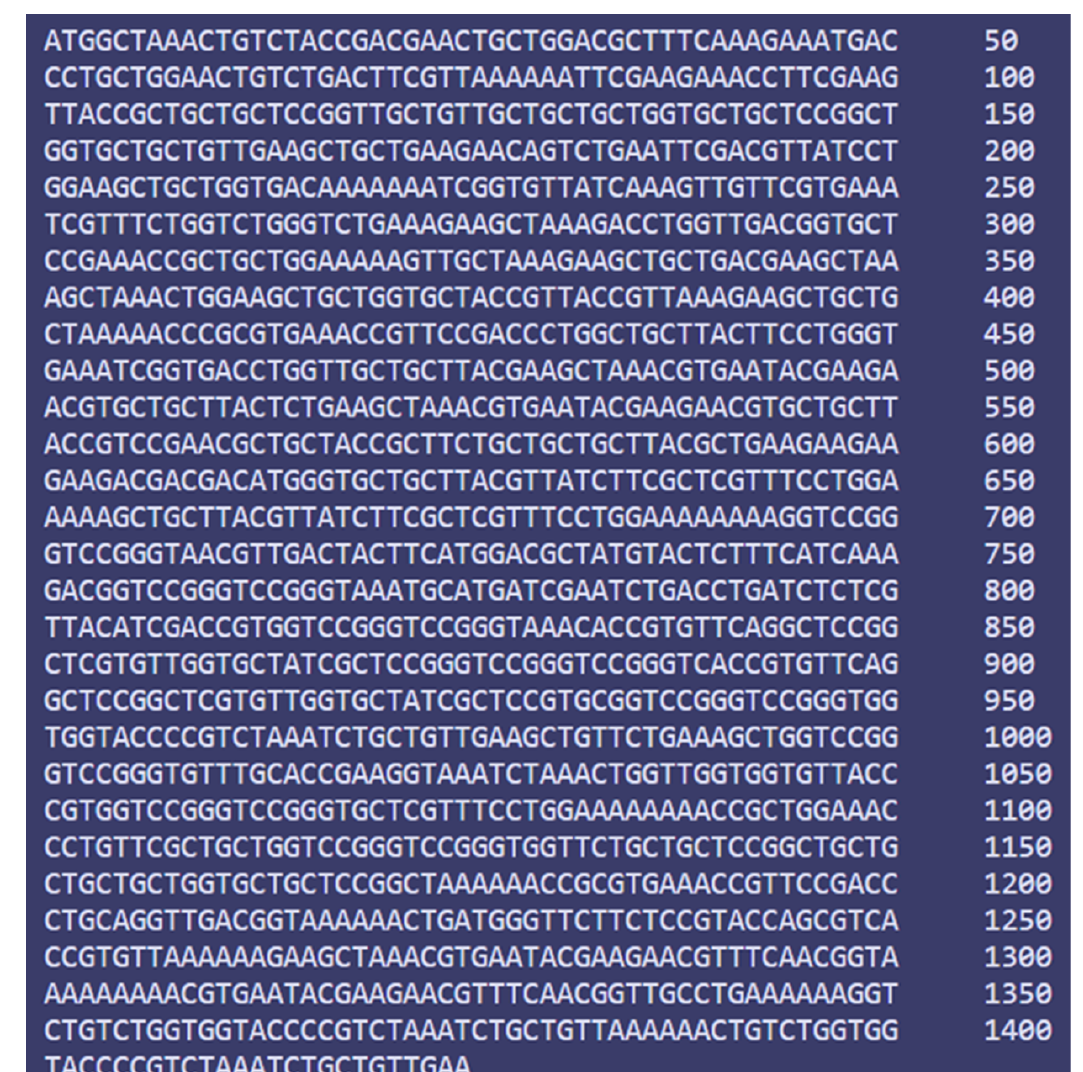
Figure 13. Codon adaptation of EBV to E. coli K12 strain.